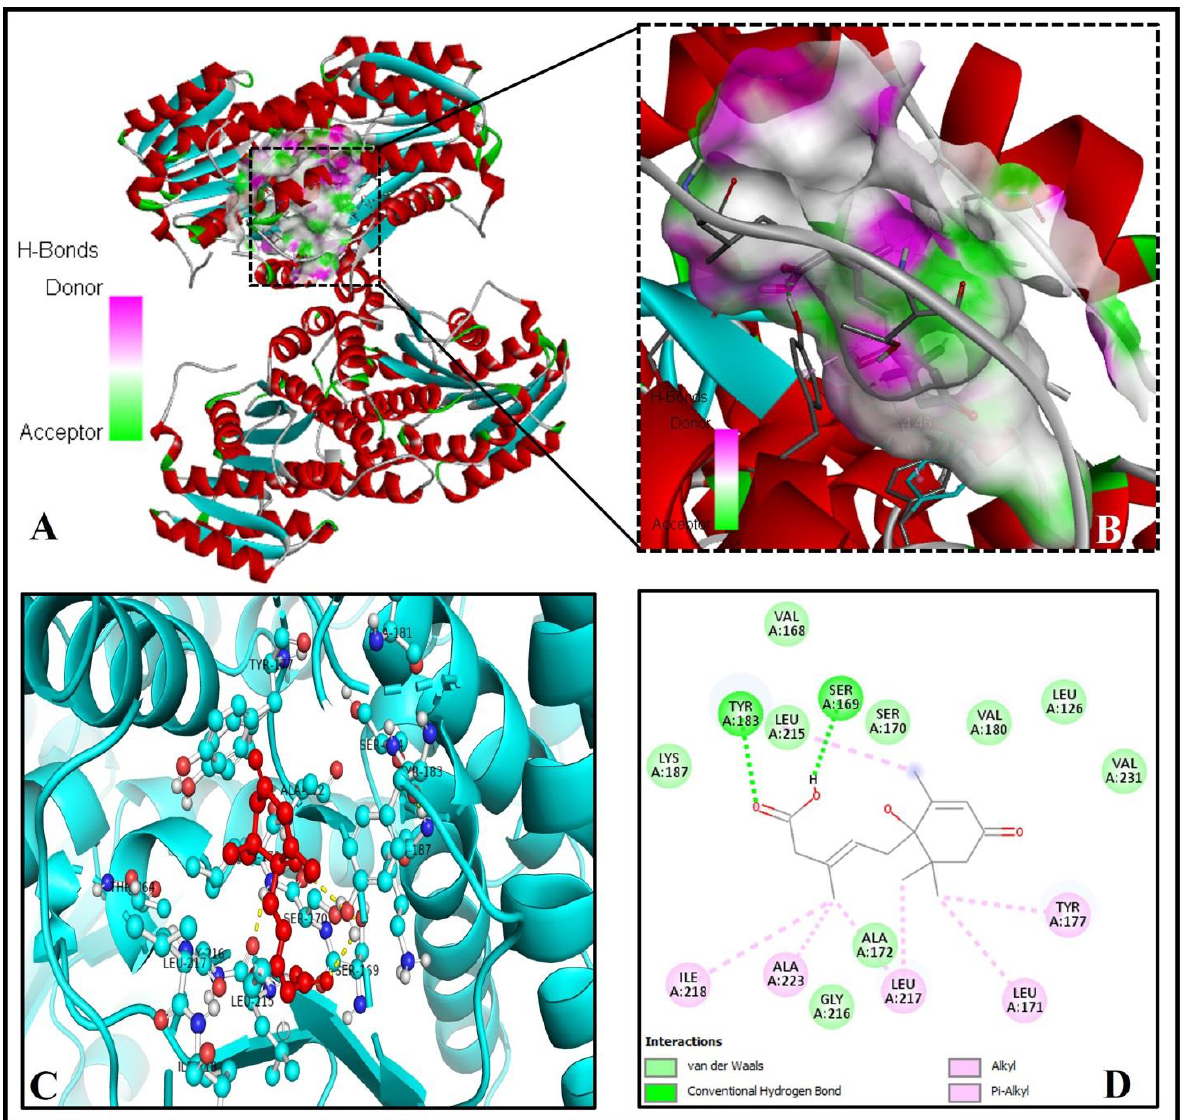
Figure 2. Significant molecular bonding of ABA with 11β -hydroxysteroid dehydrogenase1 [11β -HSD1 (PDB ID- 4K1L). ( A ) The coupling of ABA with active center residues. ( B ) The enlarged image shows the hydrogen bonds donor and acceptor amino acid residues in the junction cavity. ( C ) The 3D image shows a significant interaction of ABA (red ball and sticks) with functionally important residues (cyan ball and sticks) of human 11β -HSD1. ( D ) The 2D plot is showing the interaction of the binding pocket residues with the ABA inhibitor.